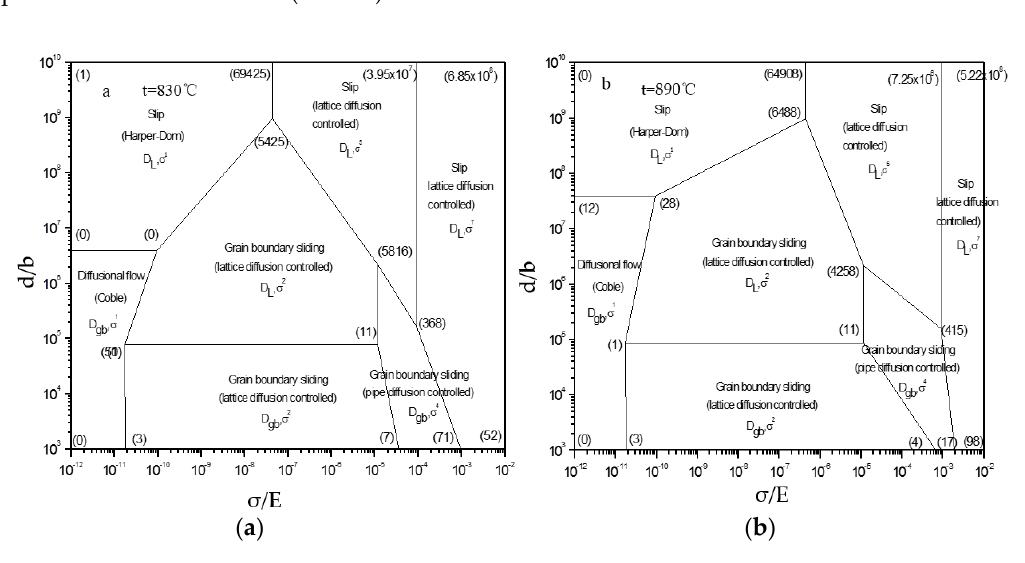
Table 4. Physical parameters of titanium alloy [41].